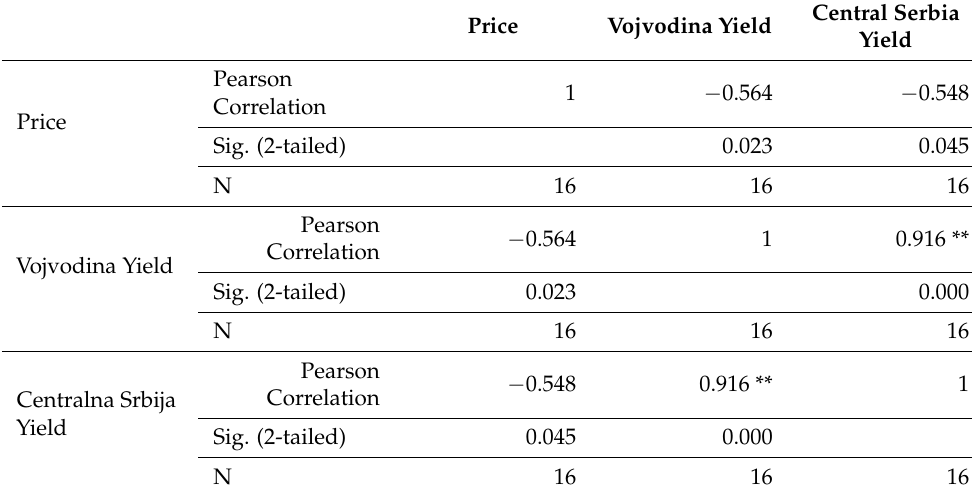
Table 6. Correlation between annual purchase price of grain maize and maize yield (t ha − 1 ) in the Republic Serbia in the period 2005–2020.